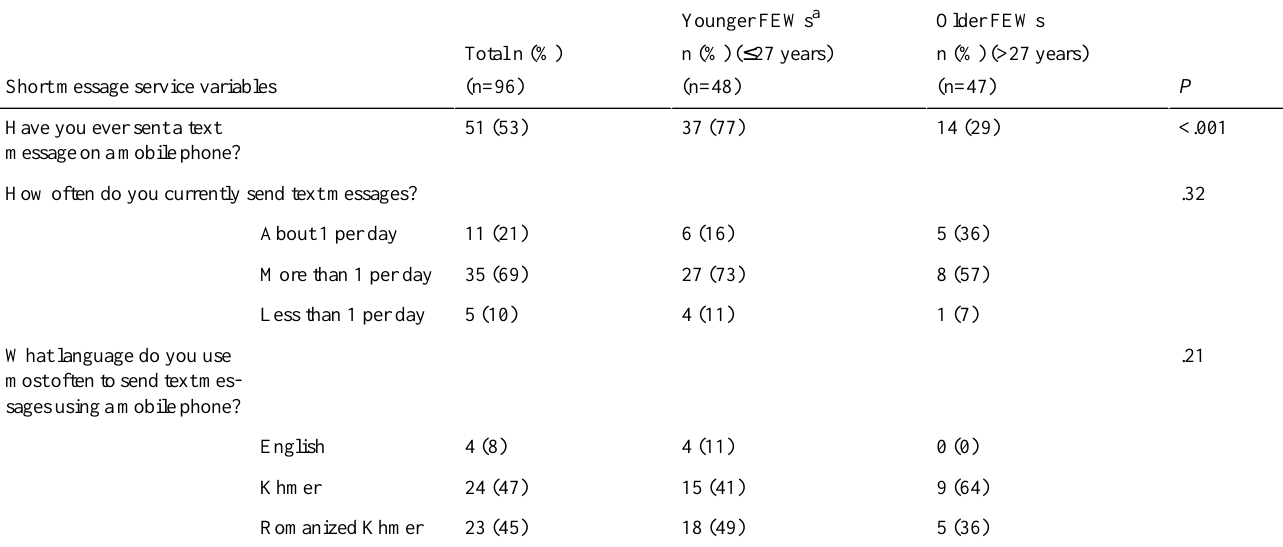
Table 2. Use of short message service by study participants by age group (n=96).